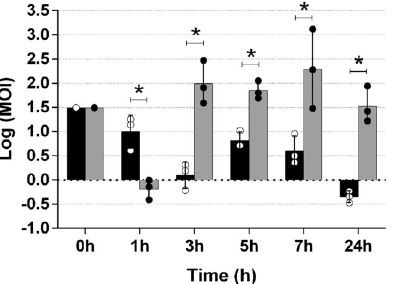
Fig. 5 Changes in the MOI during incubation of S. aureus V329 bio fi lms treated with phage phiIPLA-RODI or a combination of phage and protein CHAP-SH3b. 24-h-old bio fi lms were treated with phage at 1 × 10 9 PFU/ml (black bars) or a combination of phage at 1 × 10 9 PFU/ml and protein at 8 µM (gray bars) and incubated for 1, 3, 5, 7, or 24 h at 37 °C. Data correspond to the means ± standard deviations of three independent experiments and represent the logarithm of the MOI for each time point. Bars with an asterisk are statistically different ( p < 0.05) from each other according to the Student ’ s t-test using the Holm-Sidak method.